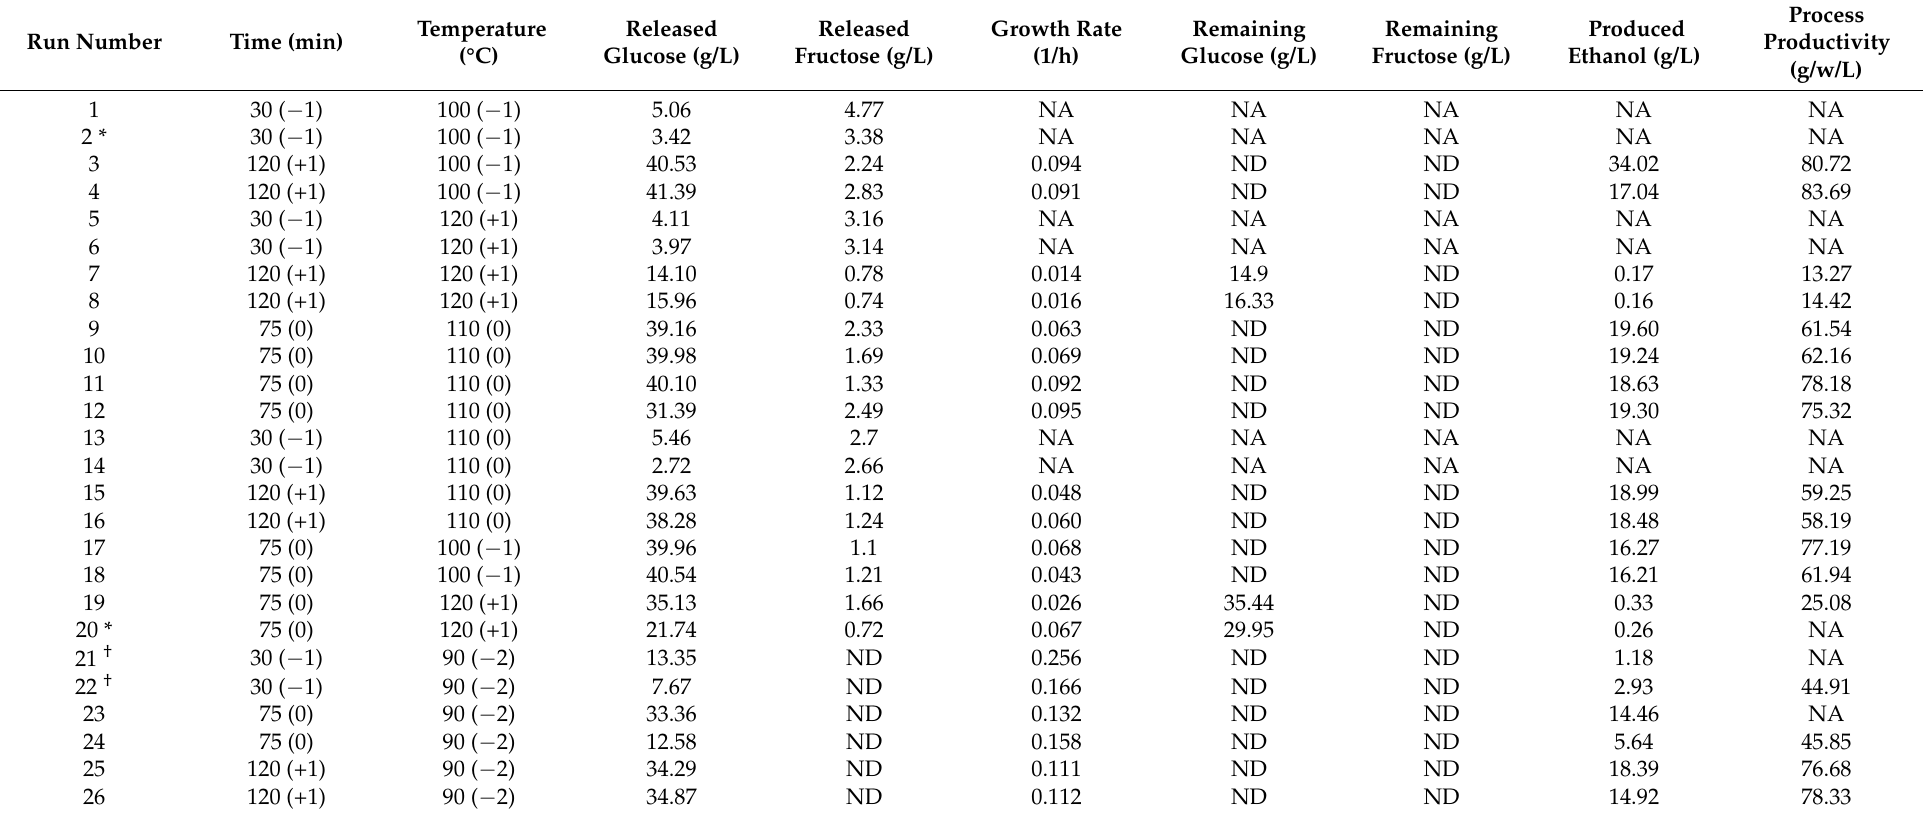
Table 4. Outputs of the different test conditions. Potato/acid ratio: 1/2. † runs for which an artifact was observed (tube not properly sealed during acid hydrolysis). * runs for which pH was over-adjusted inducing an excessive dilution. NA—Not Available, ND—Not